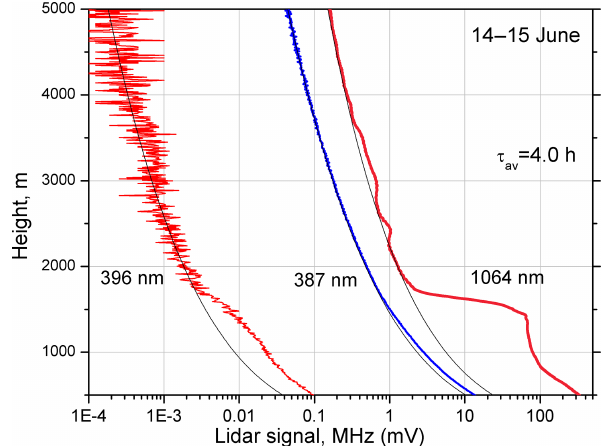
Figure 3. Lidar signals corresponding to elastic scattering at 1064nm, nitrogen Raman scattering at 387nm and methane Raman scattering at 396nm on the night of 14–15 June 2018. The units are MHz for 387 and 396nm, and mV for 1064nm. Black lines show the profiles of molecular scattering. Measurements were taken from 22:00 to 02:00UTC. Signal-averaging time t aver = 4 . 0h.